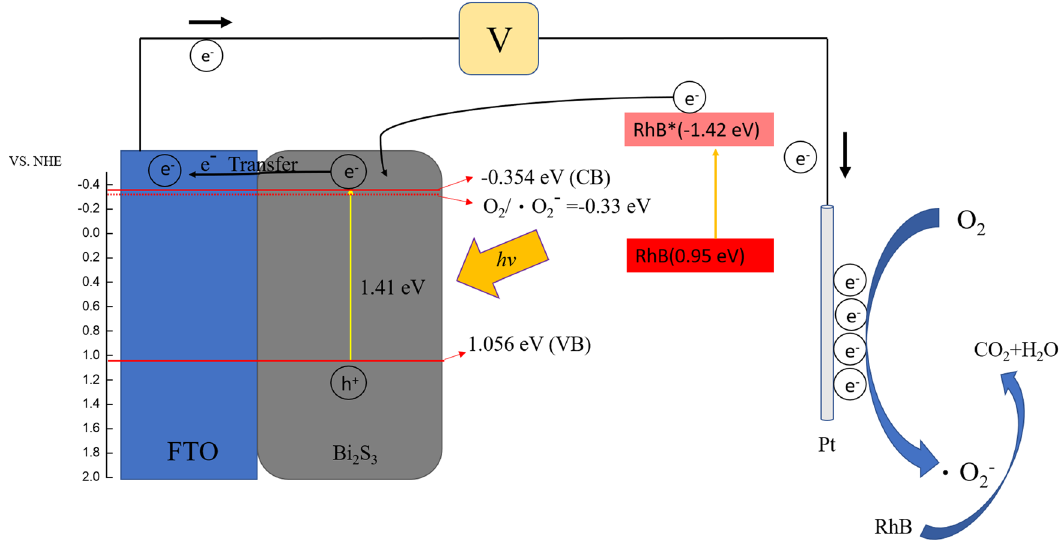
Figure 10: The possible PEC - degradation mechanism of RhB solution with Bi 2 S 3